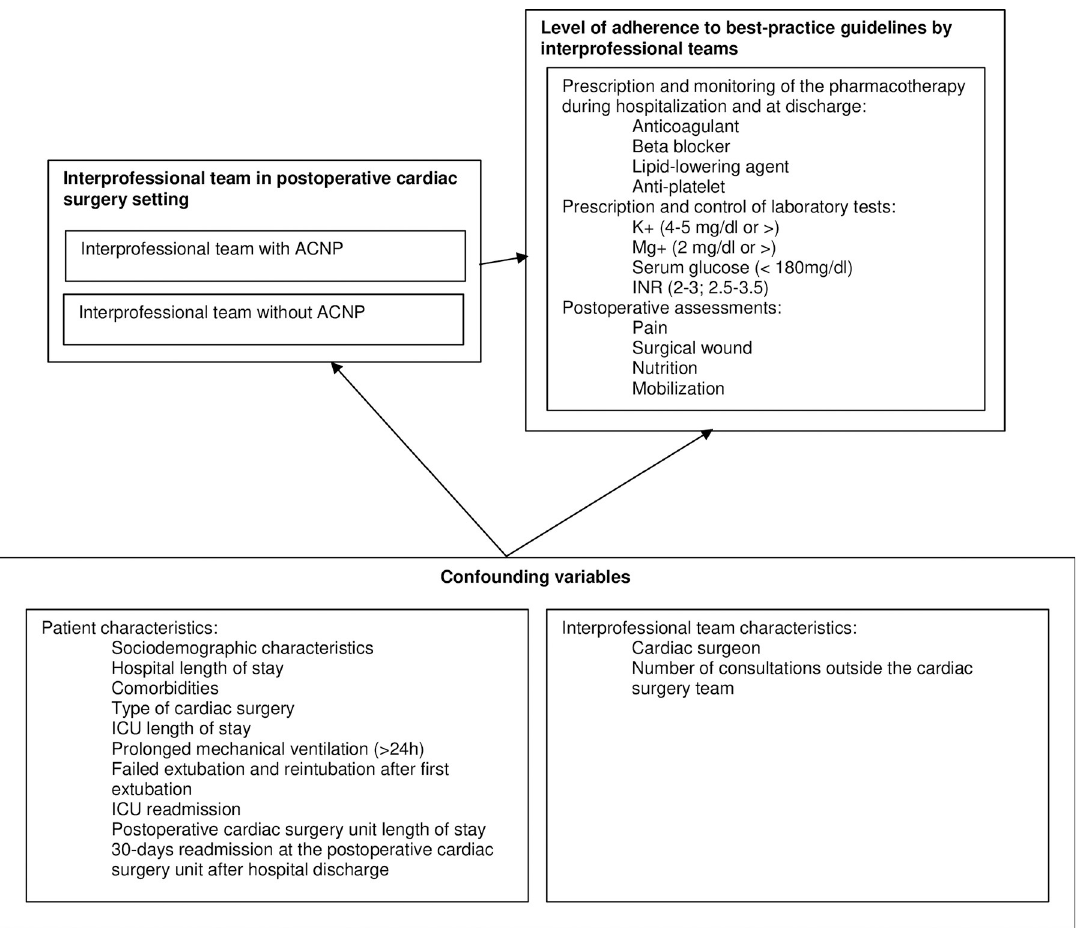
Fig 1. The influencing variables and the level of adherence to best-practice guidelines by interprofessional teams with and without acute care nurse practitioners in cardiac surgery.